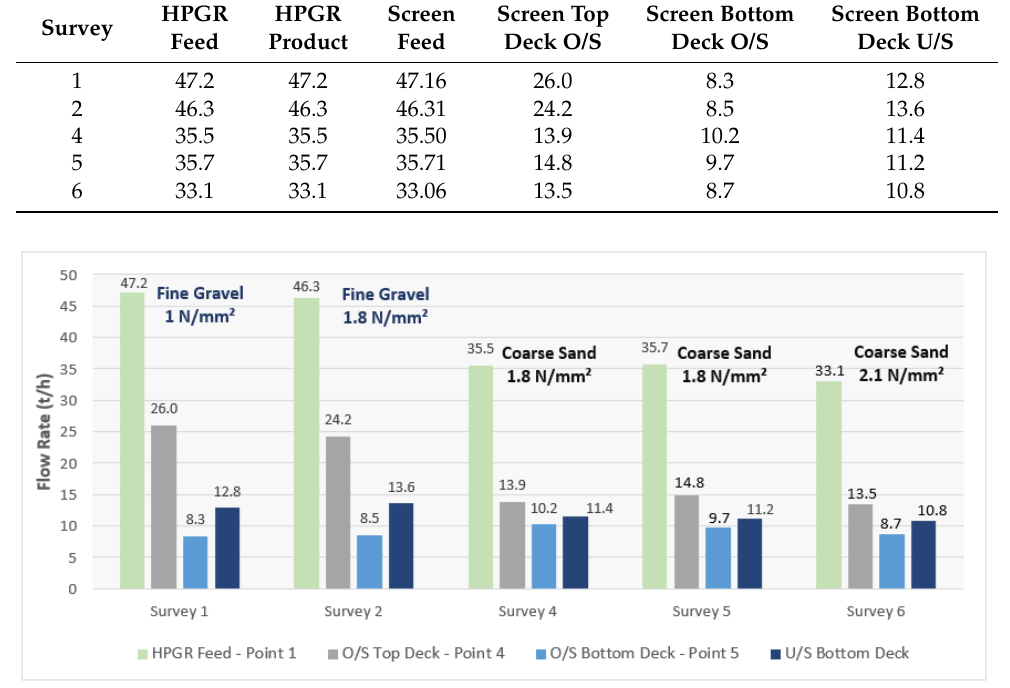
Figure 6. Summary of mass balance results.